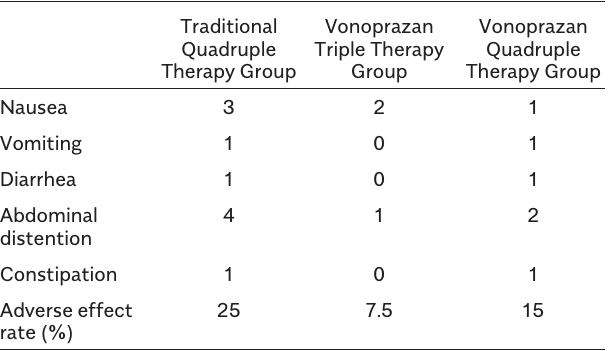
Table 3. Comparison of Adverse Effects of the 3